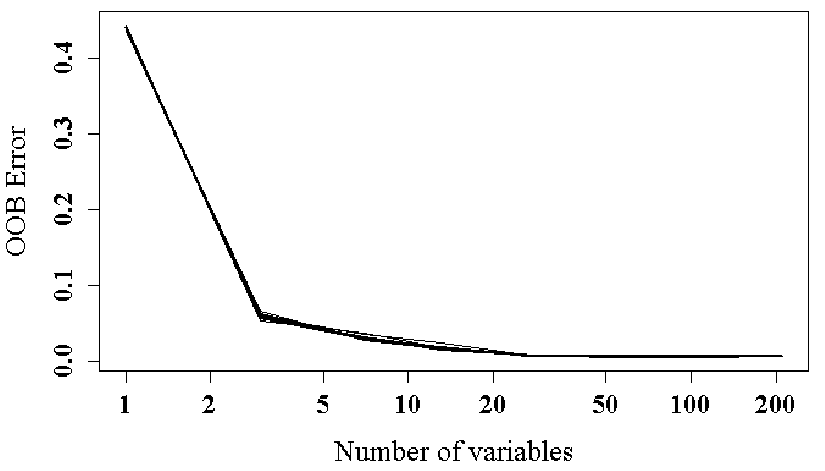
Figure 4. Effect of the number of variables on OOB error obtained by RFCV for feature selection with all 210 features.